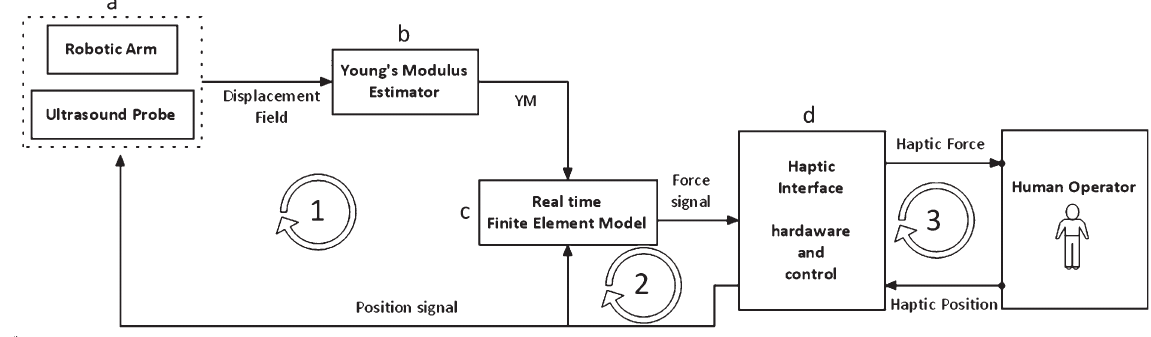
Fig. 1. The teletactile system is composed of four different modules. a) Module that controls the position of the “Ultrasound probe” connected to the “Robotic arm”. b) Module for the estimation of mechanical properties, the “Young’s modulus estimator. c) Module to synthetize the tactile input for the tactile display with the implementation of a semi-virtual environment, the “Real time finite element environment”. d) Module for the control of the “Haptic interface”. The for modules are integrated on three parallel loops. Loop (1) is the image acquisition system (robotic arm and ultrasound system) and ultrasound image processing unit for the estimation of the Young modulus data; loop (2) the Young modulus is integrated into a finite element (FE) model interfaced with a haptic device. Loop (3) represents the interaction between the human operator and the haptic